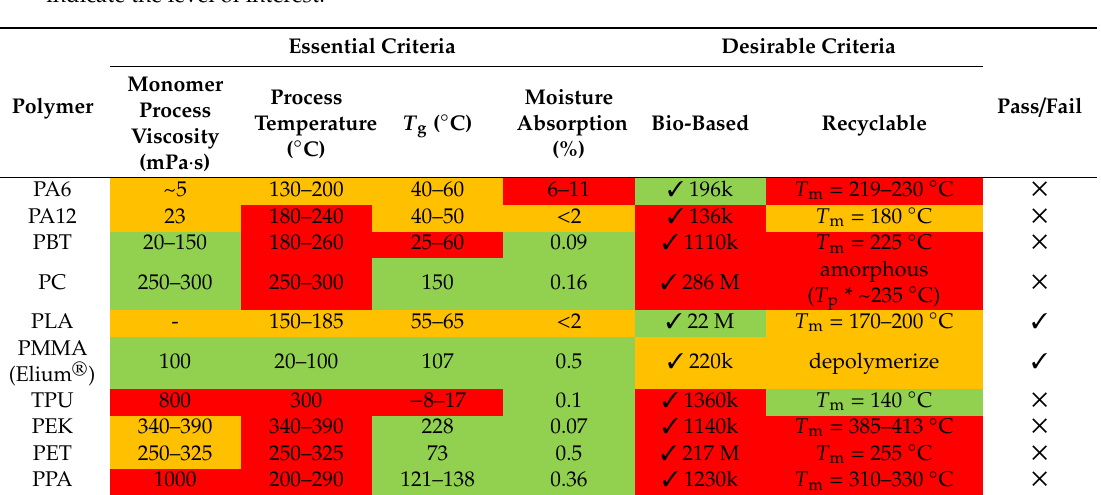
Table 4. The relative fit to requirements of the potential monomers for thermoplastic matrix marine composites (green is good, amber is marginal, red unlikely to be usable) [151,152]. Bio-based colors are based on Table 2; numbers are Google “results” searching for “bio-based xxx” on 14 June 2020 to indicate the level of